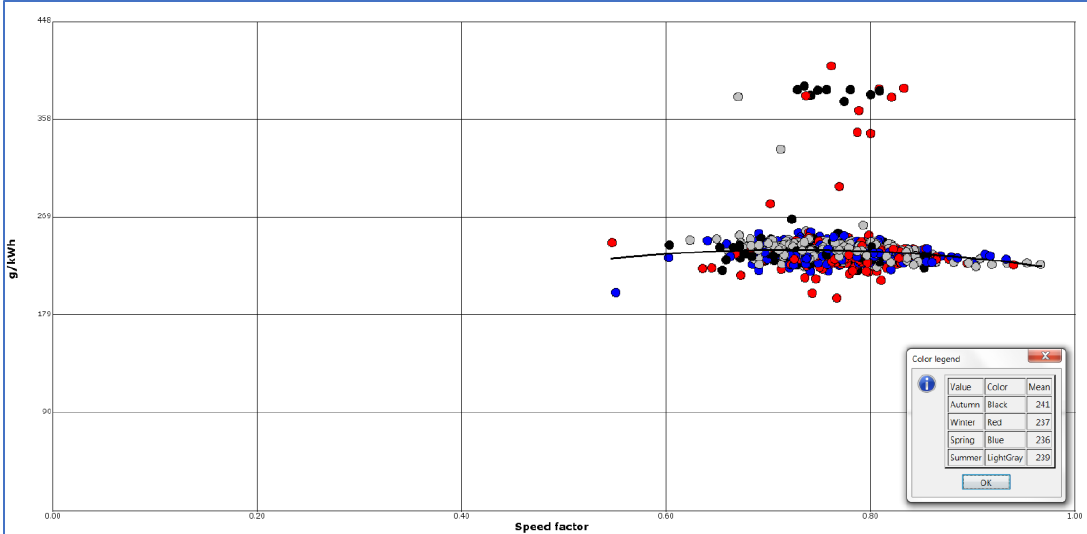
Figure 10. Specific fuel consumption (g/kWh) vs speed factor (actual speed over design speed in nautical miles pr hour) from Finnmarken. The gray line is a fitted second-degree polynomial trend line. The specific fuel consumption factor from Finnmarken data is estimated as Table 12. Coefficients for estimating specific fuel consumption from Finnmarken data.